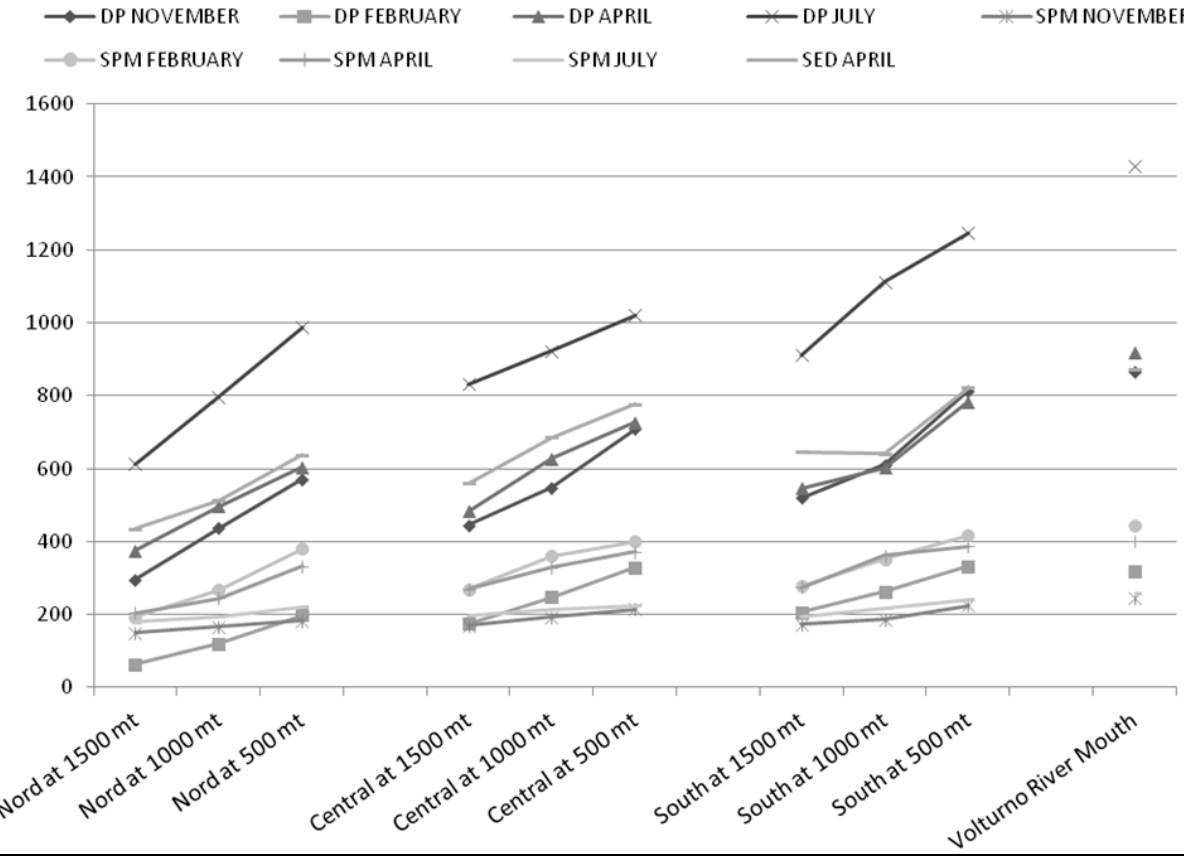
Figure 3. Spatial and temporal concentration of PAHs in the water dissolved phase (DP, ng L − 1 ), suspended particulate matter (SPM, ng L − 1 ), and sediments (ng g − 1 dry wt) of the Volturno River and Estuary, Southern Italy.